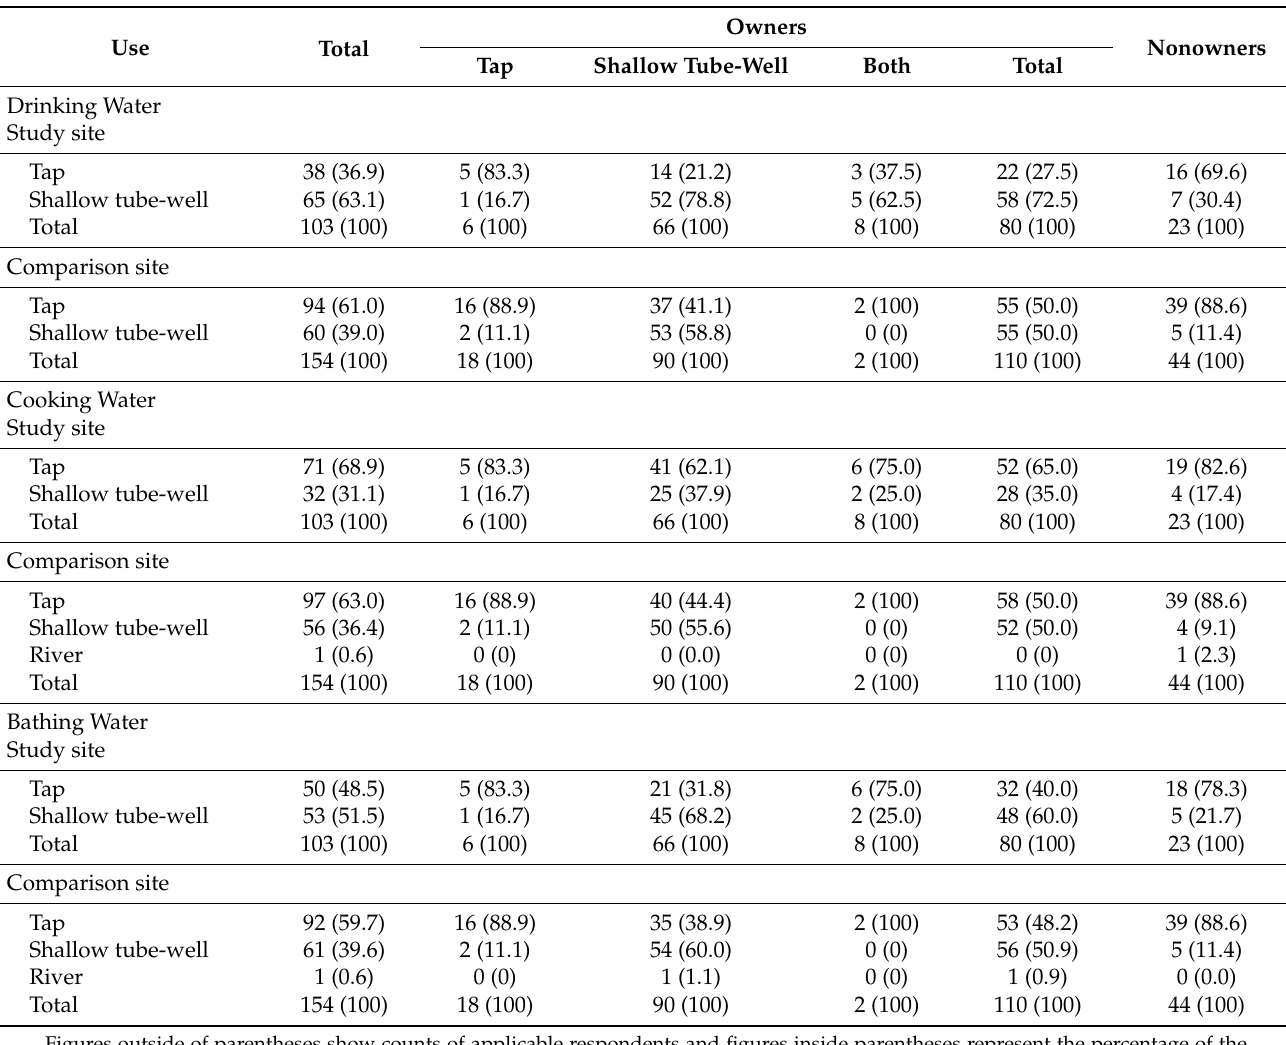
Table 4. Comparison of water source uses and possession status between the two